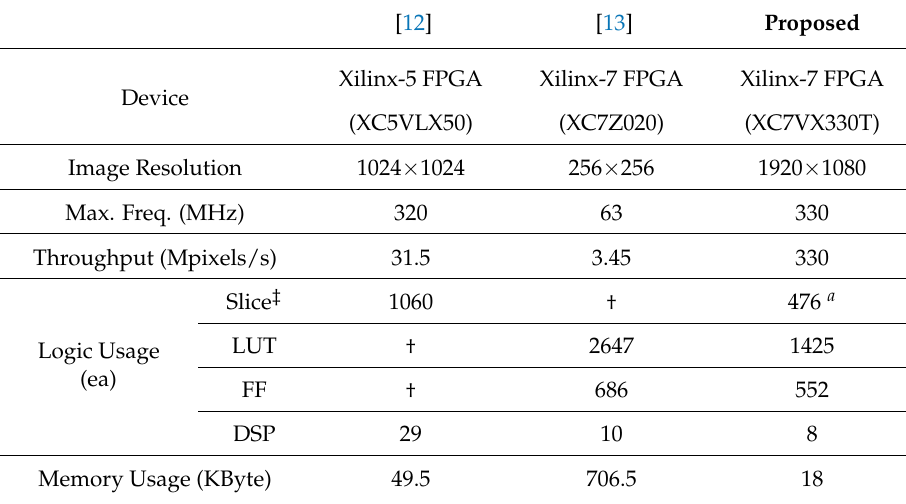
Table 3. Comparisons with State-of-the-Art VLSI Designs of Bilateral Filter.